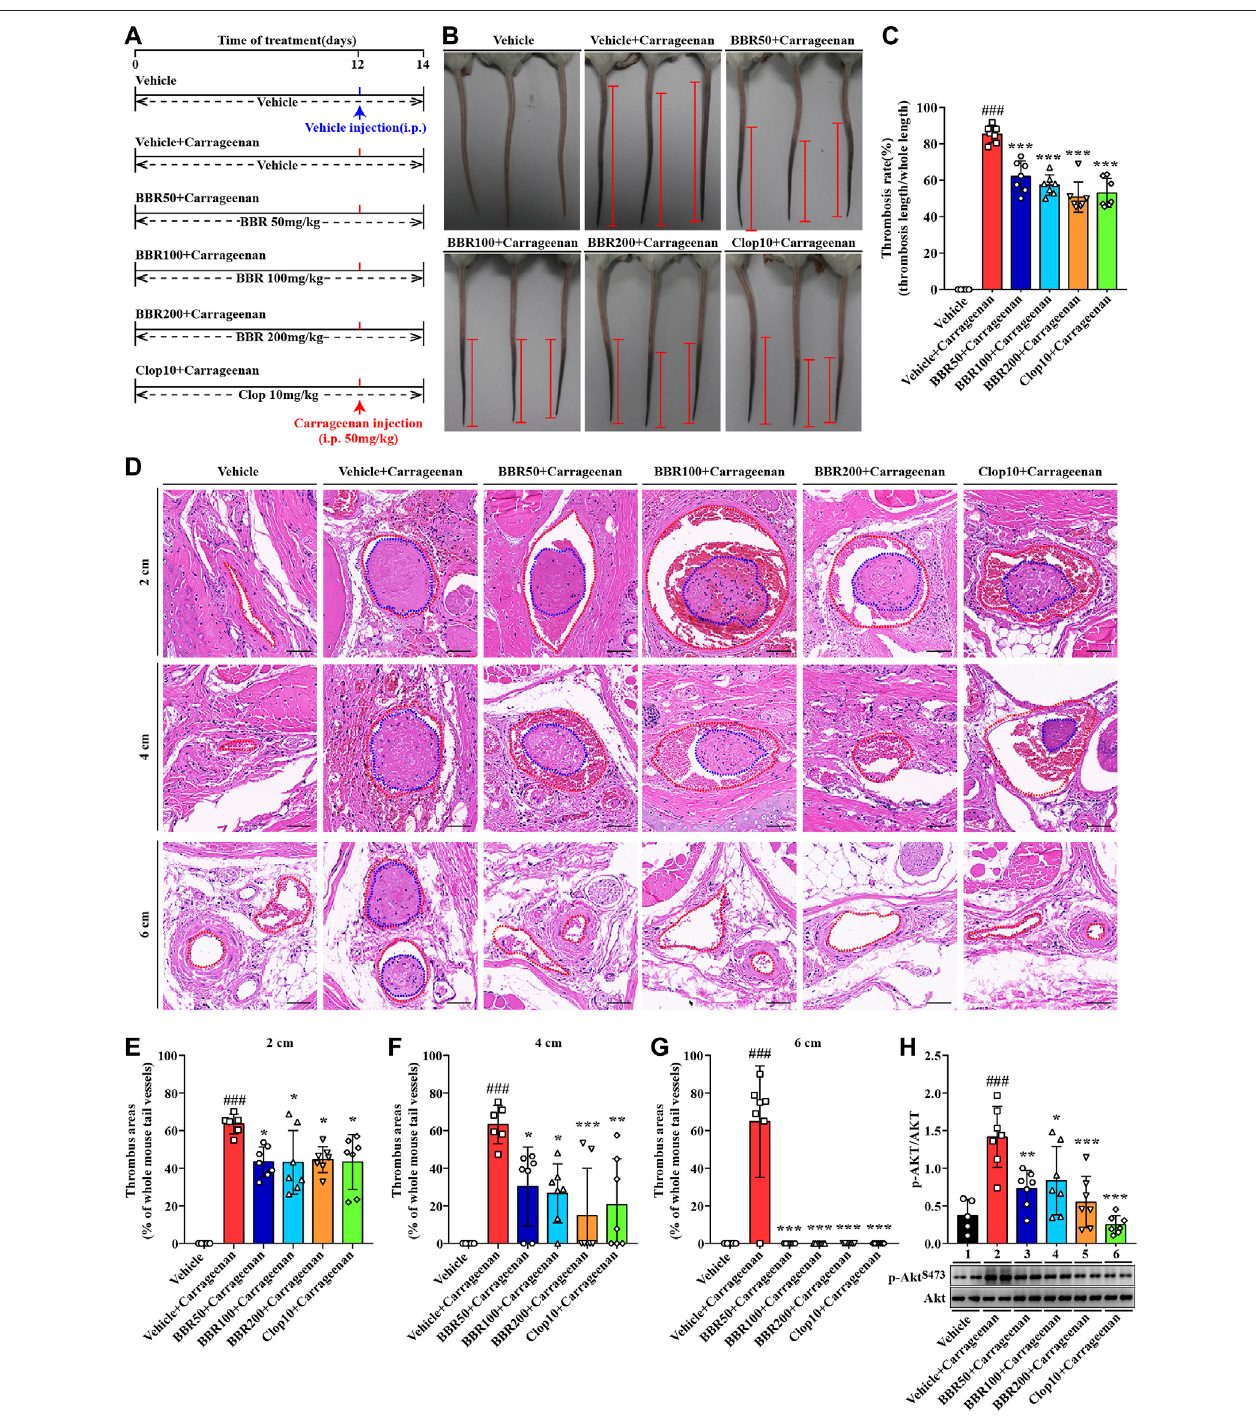
FIGURE 9 | Effects of BBR on carrageenan-induced thrombosis and Akt phosphorylation in mice. The experimental design (A) . Two days after carrageenan injection, thetailsofthemice werephotographed,and therepresentativeimages arepresented (B) ,inwhichthe blackparts inthetailsofthemice arethrombus and the red segmentsindicate the length of thrombus. The thrombosisrate was calculated and plotted as indicated (C) . The mice were sacri fi ced, and their tails were subjected toparaf fi nsectionsat2,4,and6 cmawayfromthetailtips.ThesectionswerestainedbyH&E,andthetypicalimagesarepresented (D) ( × 200,scalebar (cid:1) 50 µm). The red dotted lines represent tail vessels and the blue dotted lines represent thrombi. Thrombus areas at 2, 4, and 6 cm away from the tail tips were quanti fi ed and are presentedas thepercentagesofthe wholetail vessels ofthe mice (E-G) .The WPs wereused for protein extraction and Western blotanalysis ofthep-AKT S473 level (H) , which was normalized to Akt and plotted as indicated. Data are represented as mean ± SD of fi ve or seven mice in each group. Statistically signi fi cant differences compared with the vehicle control group are indicated by ### p < 0.001, and statistically signi fi cant differences compared with the vehicle + carrageenan group are indicated by * p < 0.05, ** p < 0.01, *** p < 0.001.